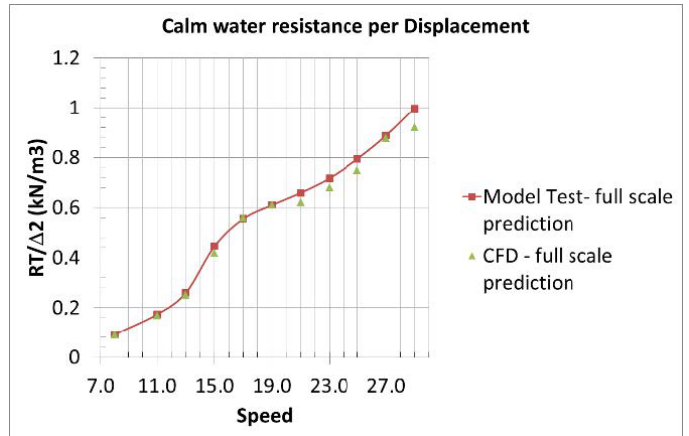
Figure 17. Prediction of the rated full-scale calm water resistance for the Stavanger demonstrator on the basis of model experiments and CFD calculations by Hamburgische Schiffbau Versuchsanstalt (HSVA) (revised hull form, battery racks on deck).